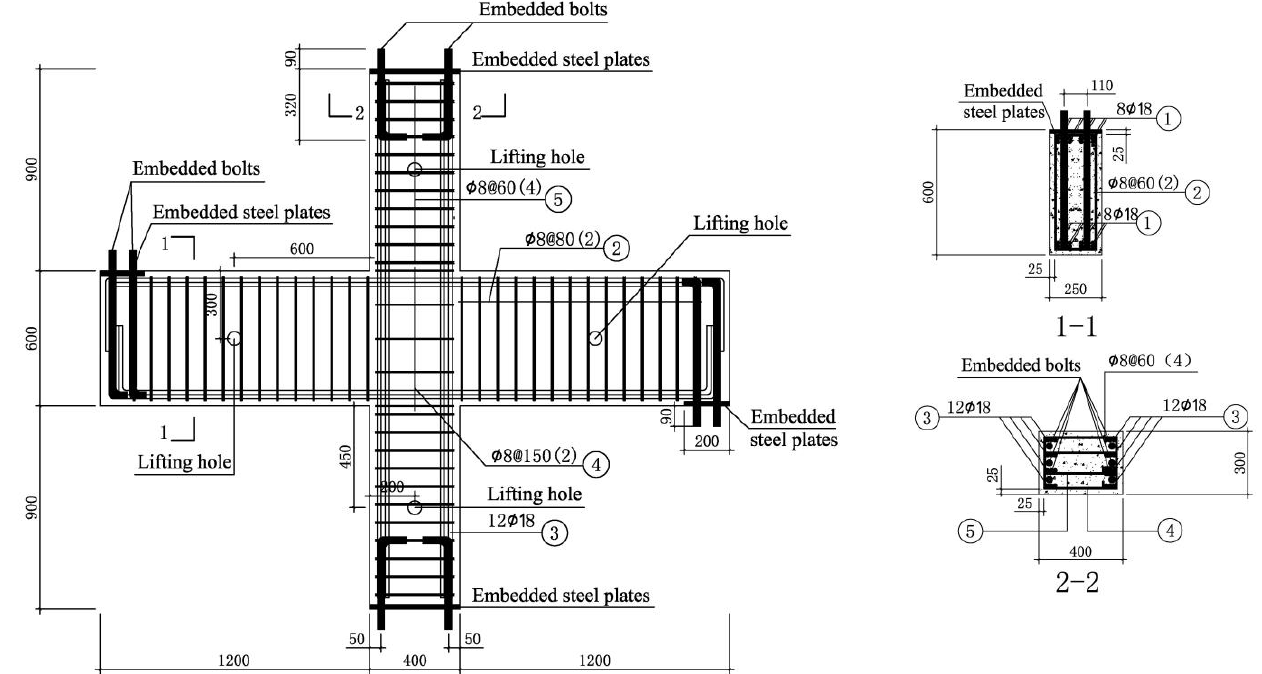
Figure 5. Dimensions and reinforcement of specimens ZJ-2 and ZJ-4 (Unit: mm).